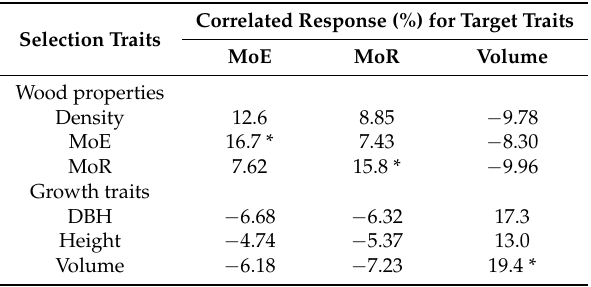
Table 3. Correlated genetic responses for three breeding target traits with 10% selection